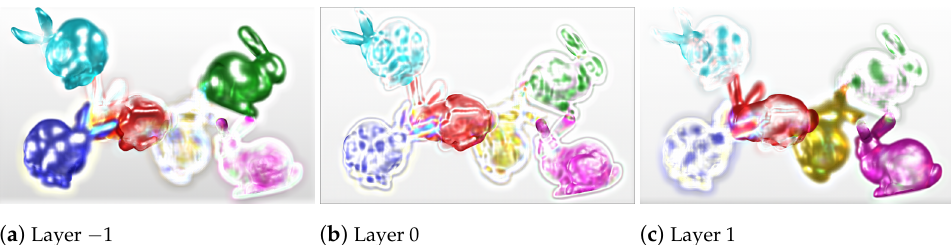
Figure 3. The three optimal multiplicative layers obtained from CNN (with 20 convolutional layers, trained for 20 epochs with a learning rate of 0.0001, and batch size 15) for Bunnies data ( BLOCK I of the proposed